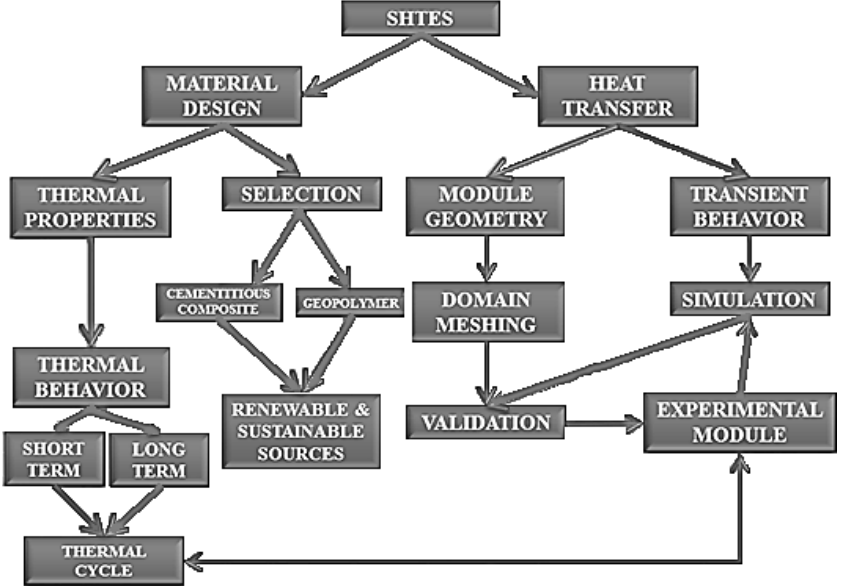
Figure 1. Schematization of sensible heat thermal energy storage (SHTES)